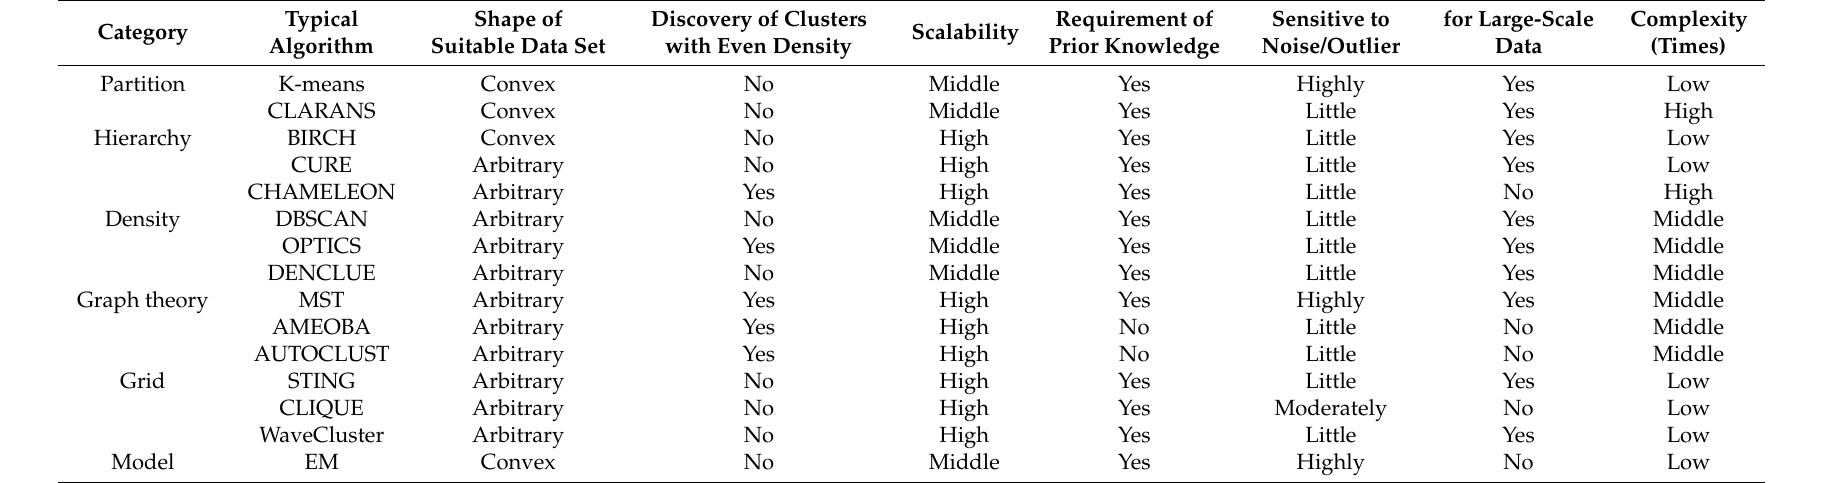
Table 1. Comparisons of some classical spatial clustering